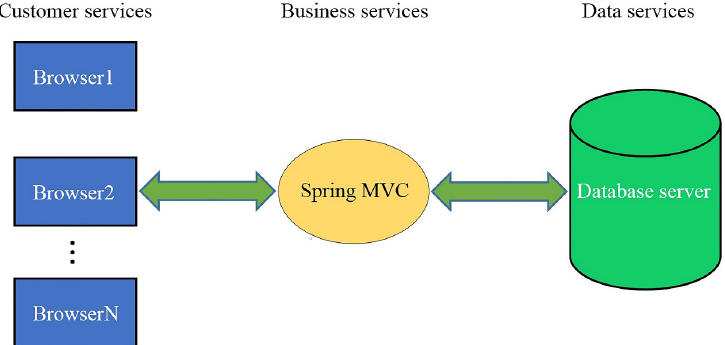
Fig. 1 System development technology architecture